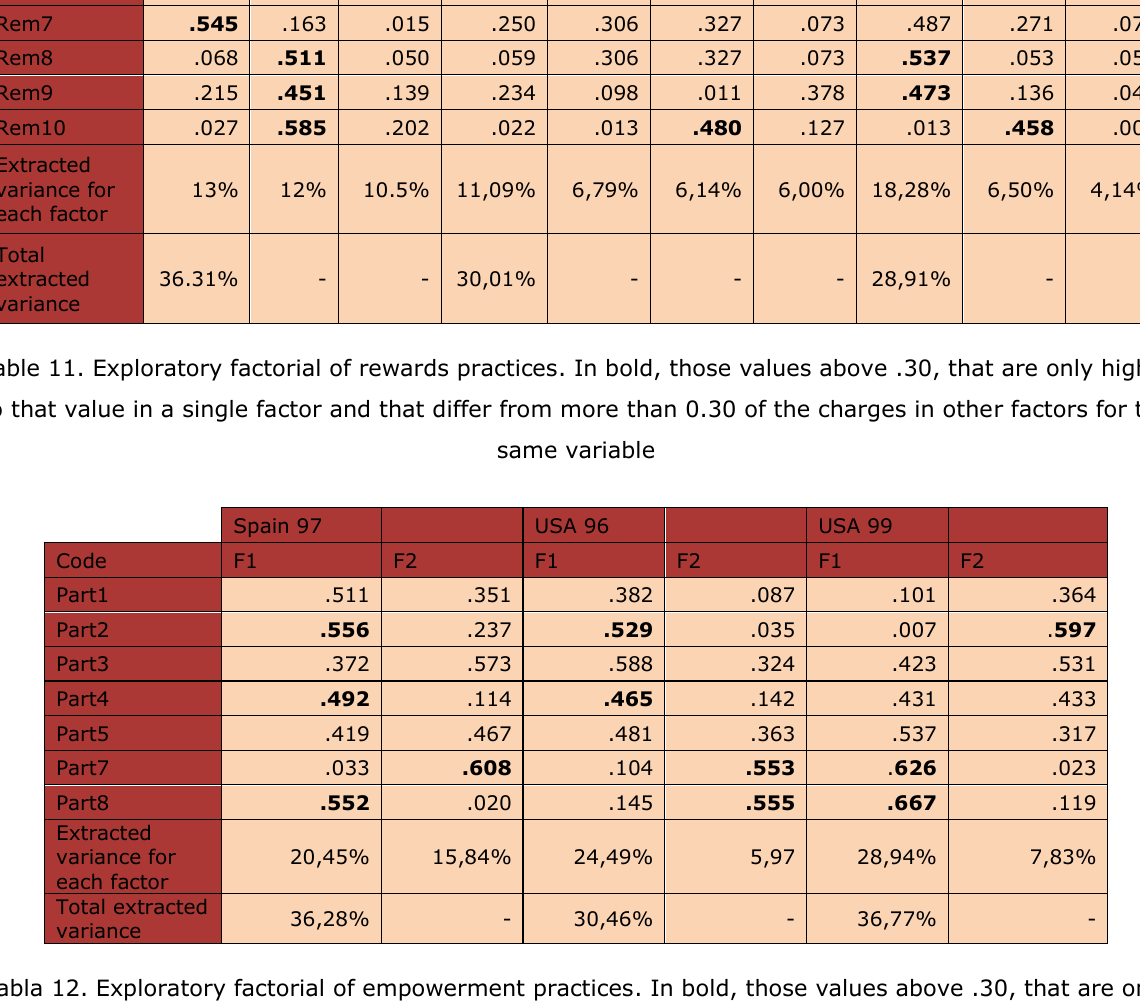
Tabla 12. Exploratory factorial of empowerment practices. In bold, those values above .30, that are only higher to that value in a single factor and that differ from more than 0.30 of the charges in other factors for the same